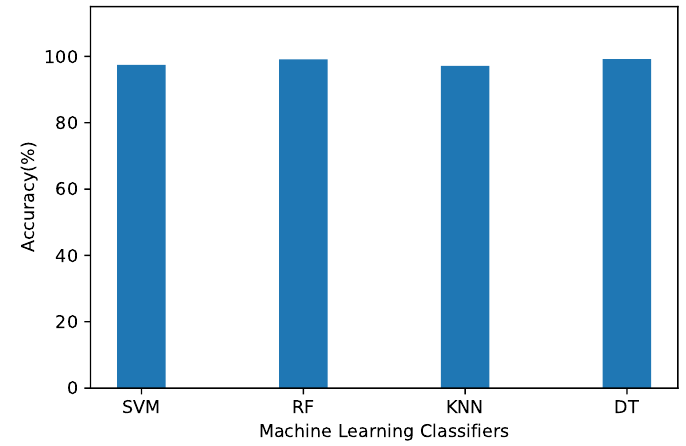
Figure 4. Average accuracy of machine learning